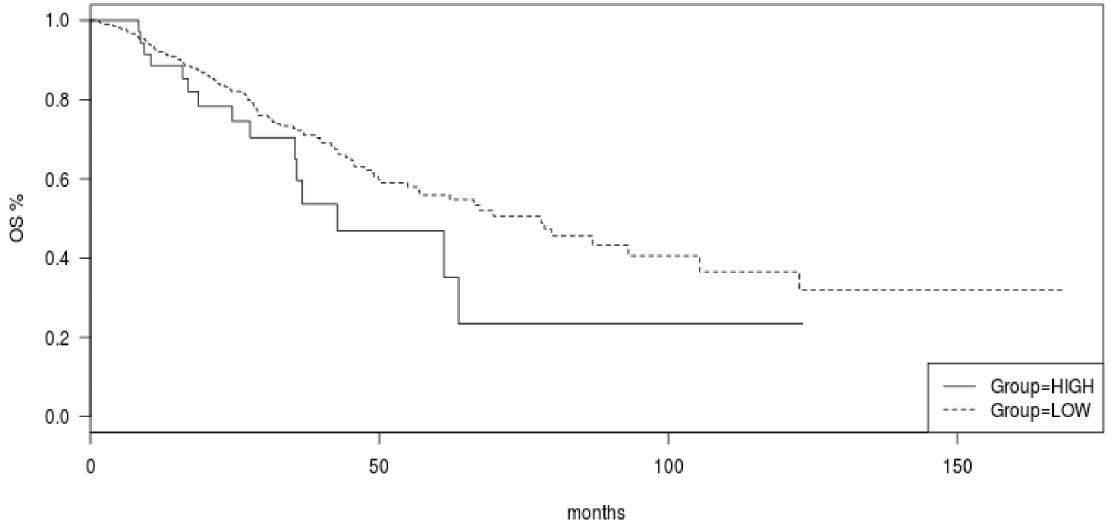
Figure 9. Overall survival (OS) of ER-positive/HER2-negative breast cancers according to total mutation count in the DFCI metastatic breast cancer cohort. Log Rank p =